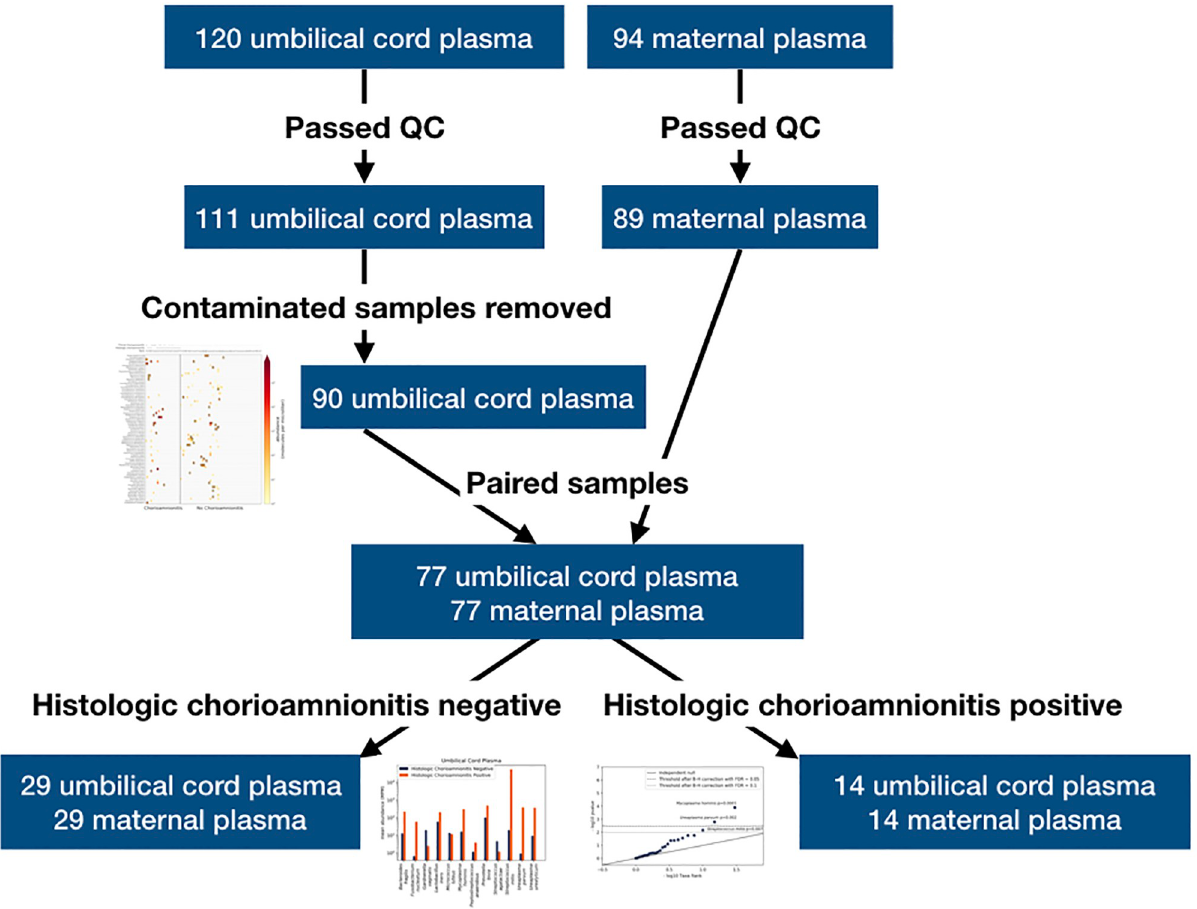
Fig 1. Diagram of sample processing and